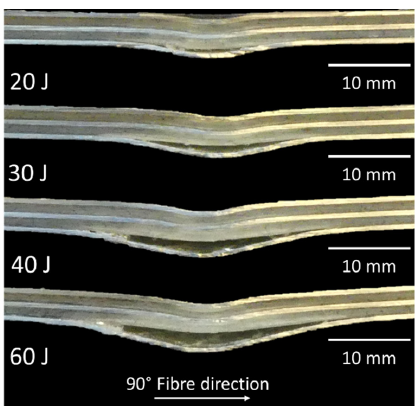
Figure 10. Cross ‐ sectional view of the impacted area of the FML at different impact energies.